Question: In one sentence, what is this figure communicating?
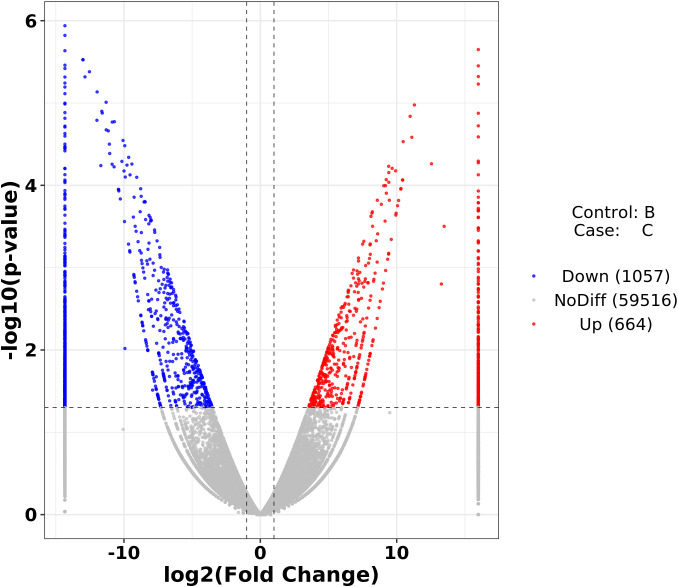
Answer: The volcano plot of DEGs. The horizontal coordinate is log2FoldChange and the vertical coordinate is -log10 (p-value). The two vertical dotted lines are 2 times the difference threshold and the horizontal dotted lines are p-value = 0.05. Red dots indicate up-regulated genes, blue dots indicate down-regulated genes, and gray dots indicate non-significantly differentially expressed genes.